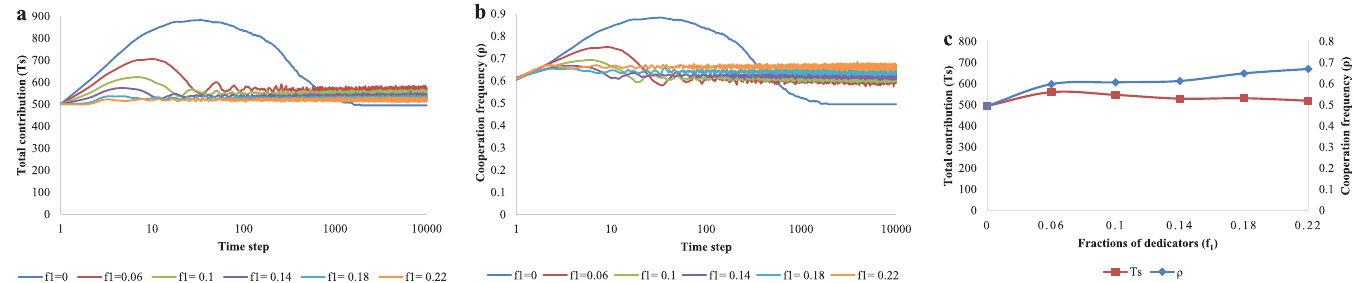
Fig 5. The evolution results of total contributions Ts and cooperation frequency ρ for different fractions of dedicators f 1 . (a) The evolution process of total contributions for different fractions of dedicators ( f 1 = 0, 0.06, 0.1, 0.14, 0.18, 0.22). (b) The evolution results of cooperation frequency for different fractions of dedicators ( f 1 = 0, 0.06, 0.1, 0.14, 0.18, 0.22). (c) The equilibrium results of total contributions and cooperation frequency for different fractions of dedicators ( f 1 = 0, 0.06, 0.1, 0.14, 0.18, 0.22).